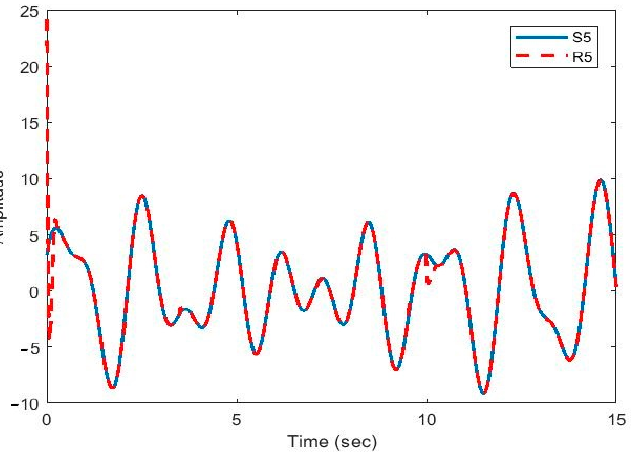
Figure 13. Plot of original signal (S (cid:2873) ) and recovered signal (R (cid:2873) ) obtained using multi-state syn- chronization and chaotic masking.